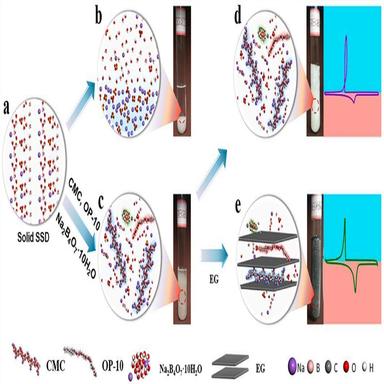
(a) solid Na2SO4⋅10H2O, (b) liquid Na2SO4⋅10H2O, (c) liquid Na2SO4⋅10H2O-CBO, Na2SO4⋅10H2O with Na2B4O7⋅10H2O, CMC and OP-10, (d) Na2SO4⋅10H2O-CBO and DSC curve with the drastic recalescence in the freezing peak, and (e) Na2SO4⋅10H2O-CBO/expanded graphite hydrated salt phase change material and DSC curve without recalescence in the freezing peak . Reproduced with the permission of Elsevier.